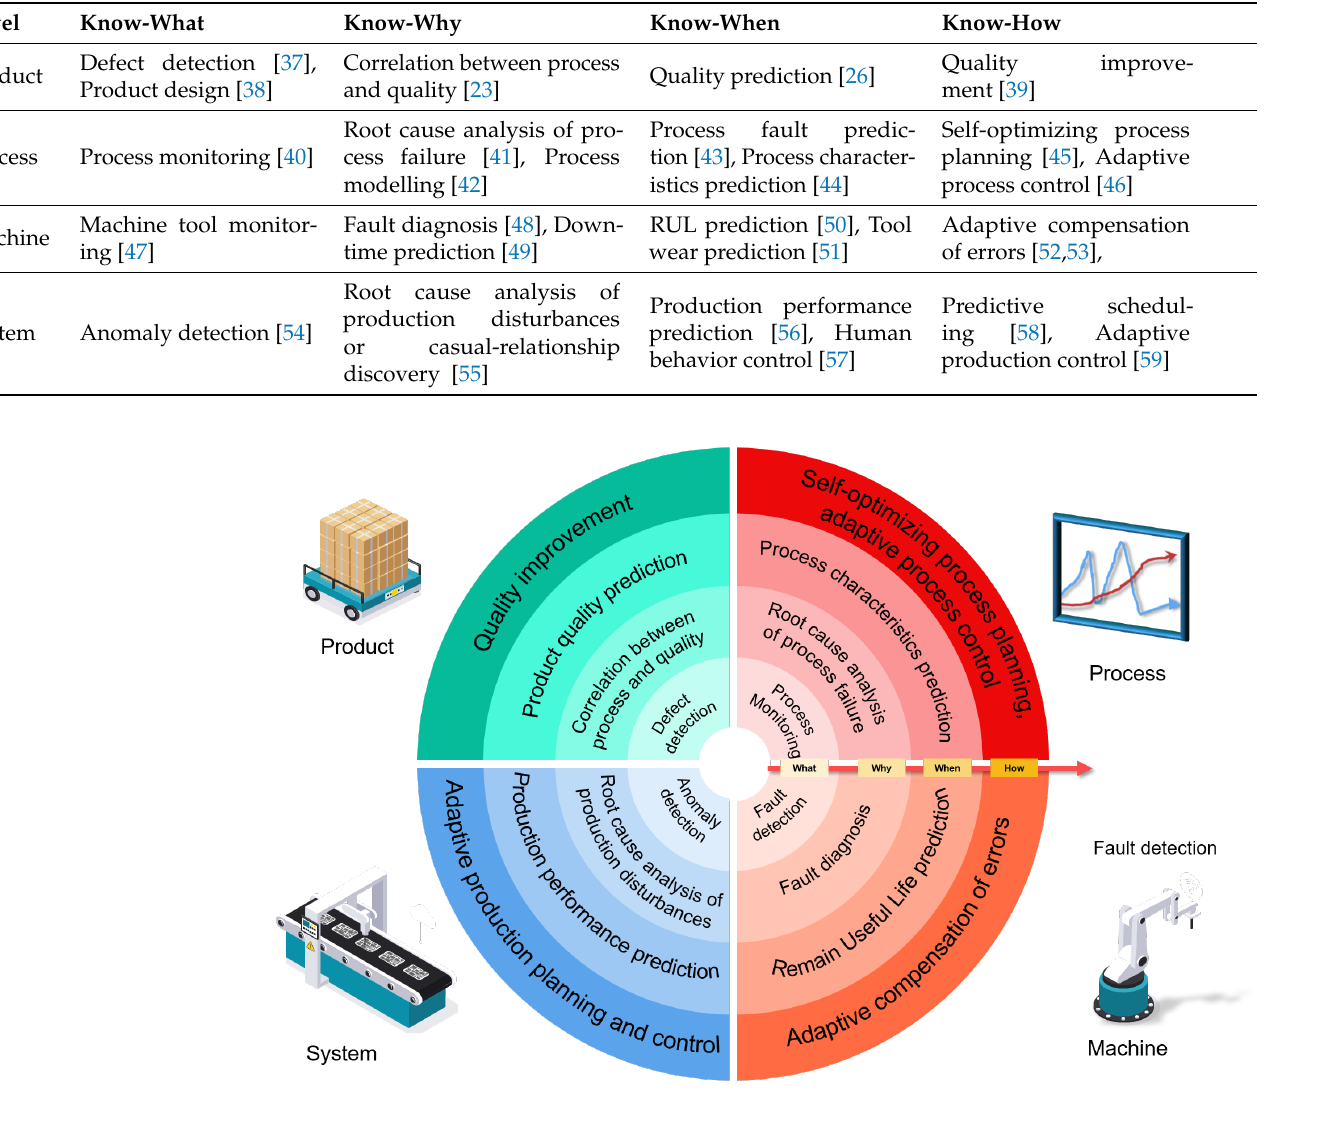
Figure 1. Four-Level and Four-Know categorization of ML applications. The Four-Know categories, from Know-what to Know-how, are respectively demonstrated by the four concentric circles, from the inner circle to the outer circle, with each circle divided into four quarters according to the Four